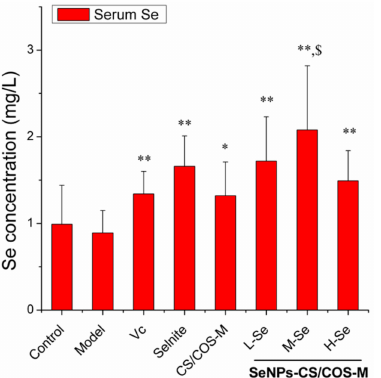
Figure 5. The serum Se retention within KM mice. The dose of each group is presented in Table 1. * p < 0.05, ** p < 0.01 versus the Model group; $ p < 0.05 versus the CS / COS microsphere (CS / COS-M)